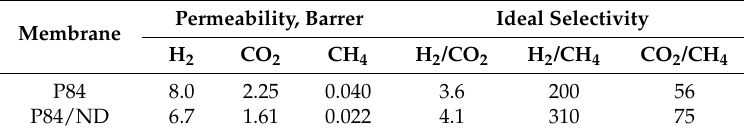
Table 3. Transport properties of membranes, 30 ◦ C.